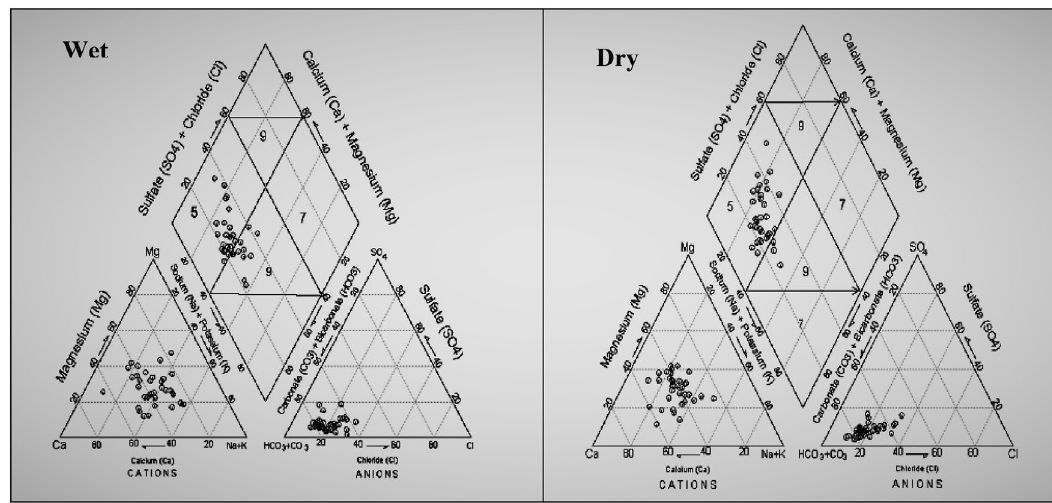
Fig. 12 Piper diagram of SW